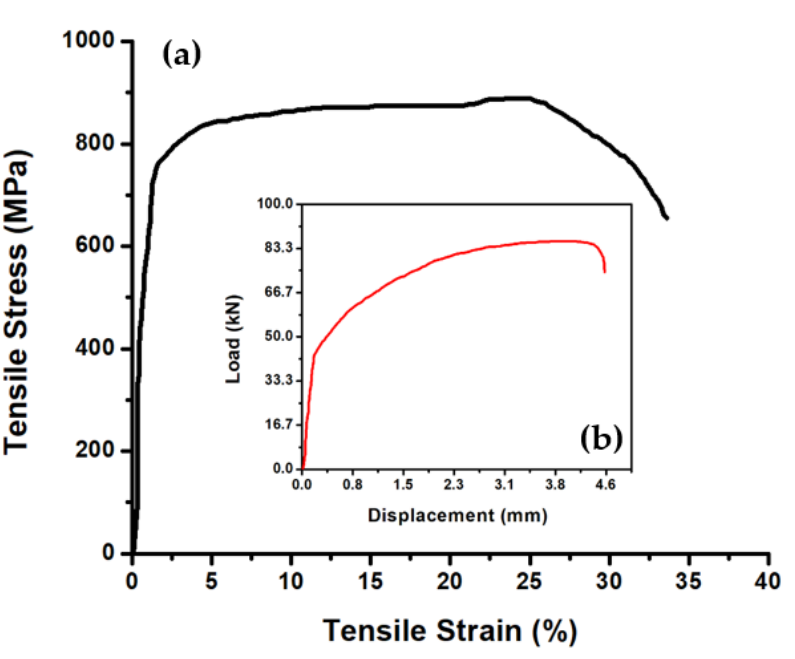
Figure 2. Stress–strain curve ( a ) and deformation curve ( b ) for the base material.